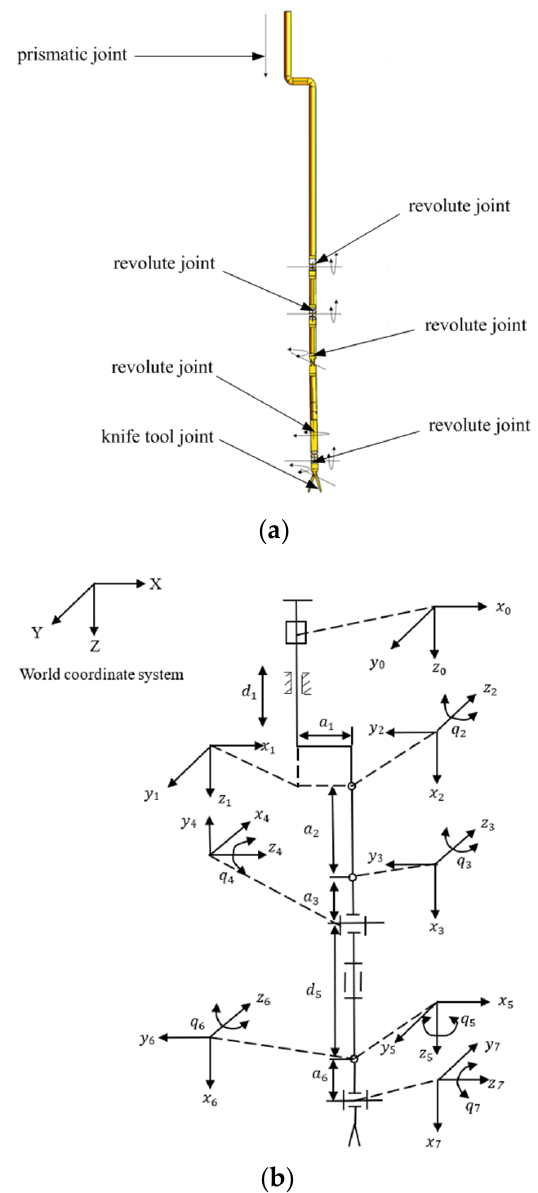
Figure 5. ( a ) The structure diagram of the 7-DOF manipulator; ( b ). The coordinate system of the 7-DOF manipulator.